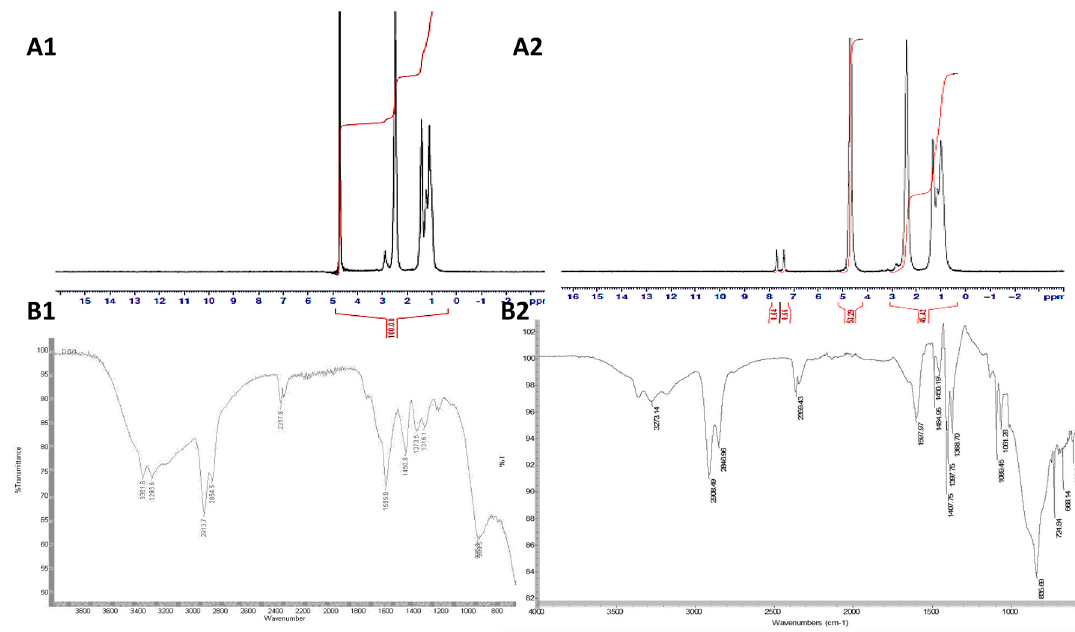
Figure 2. Chemical characterisation of ( A1 ) PAA using proton nuclear magnetic resonance ( 1 H NMR) spectroscopy, ( A2 ) PAA-Ox5 using proton nuclear magnetic resonance ( 1 H NMR) spectroscopy, ( B1 ) PAA using attenuated total reflectance–fourier transform infrared (FTIR-ATR) spectroscopy and ( B2 ) PAA-Ox5 using attenuated total reflectance–fourier transform infrared (FTIR-ATR) spectroscopy.